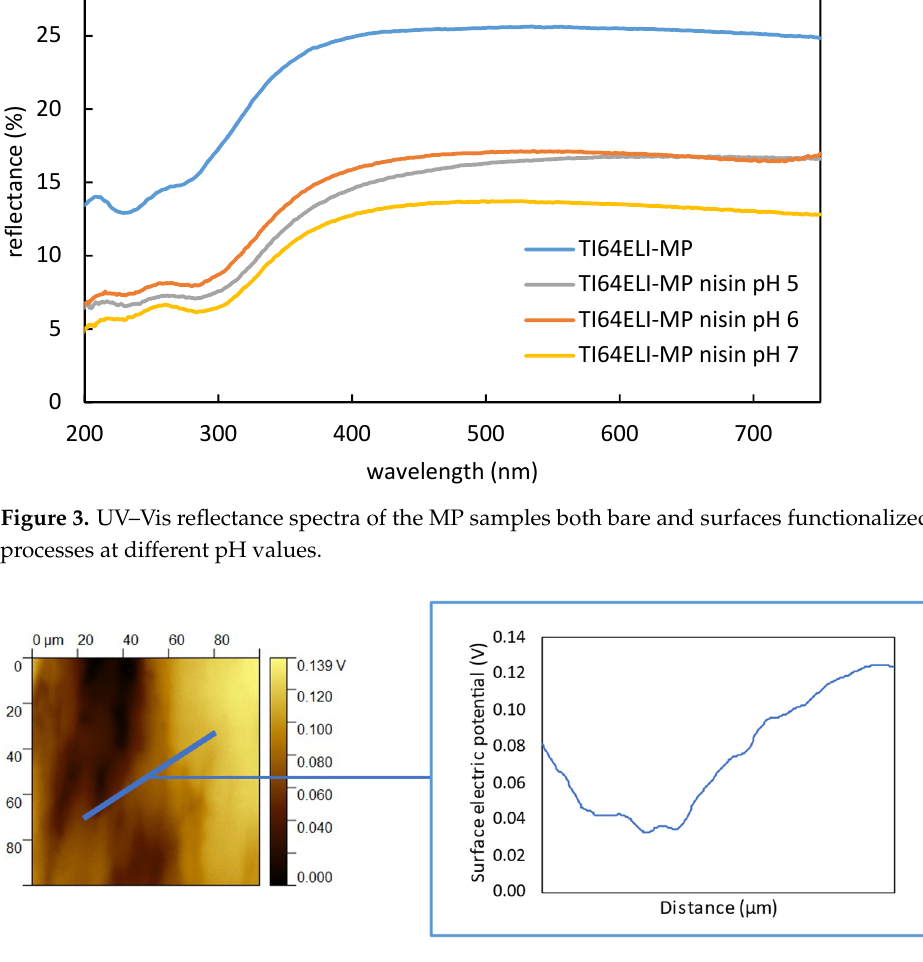
Figure 5. The contact angles measured on the bare MP sample (grey), samples functionalized with processes at different pH values (orange), and control samples soaked in solutions at different pH without nisin (blue). It must be considered an eventual contribution due to a modification of the titanium oxide layer during the soaking in solutions at different pH, regardless of the presence of nisin. This effect has been taken into account by considering some control samples soaked, at any pH value, in analogous solutions without nisin (TI64MP-CTRL, blue bars in Figure 4). As displayed in Figure 5, the contact angle of the control samples decreases by increasing the pH of the solution. The opposite phenomenon is observed for the samples functionalized with nisin. At first, these data confirm the presence of nisin on the functionalized samples because of a different wettability than the bare and the control 0